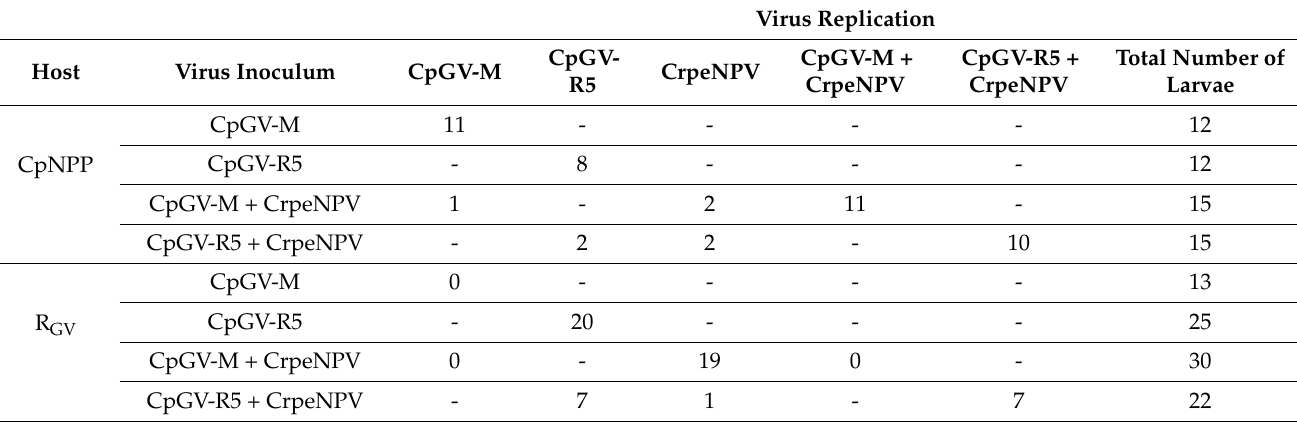
Table 1. Replication of virus inocula on the two insect host colonies. Number of larvae showing amplification of the specific PCR fragment after ingestion of the corresponding virus or virus mixture.